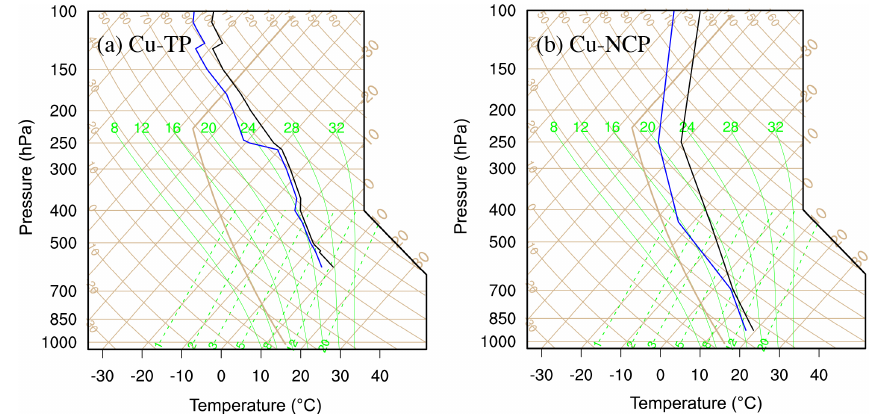
Figure 1. Atmospheric sounding (a) over the Tibetan Plateau (87.08 ◦ E, 28.63 ◦ N, 4302ma.s.l.) at 08:00UTC on 12 August 2014 and (b) over North China Plain (114.35 ◦ E, 37.17 ◦ N, 181ma.s.l.) at 08:00UTC on 24 August 2014. The black line corresponds to the tempera- ture, and the blue line represents the dew point